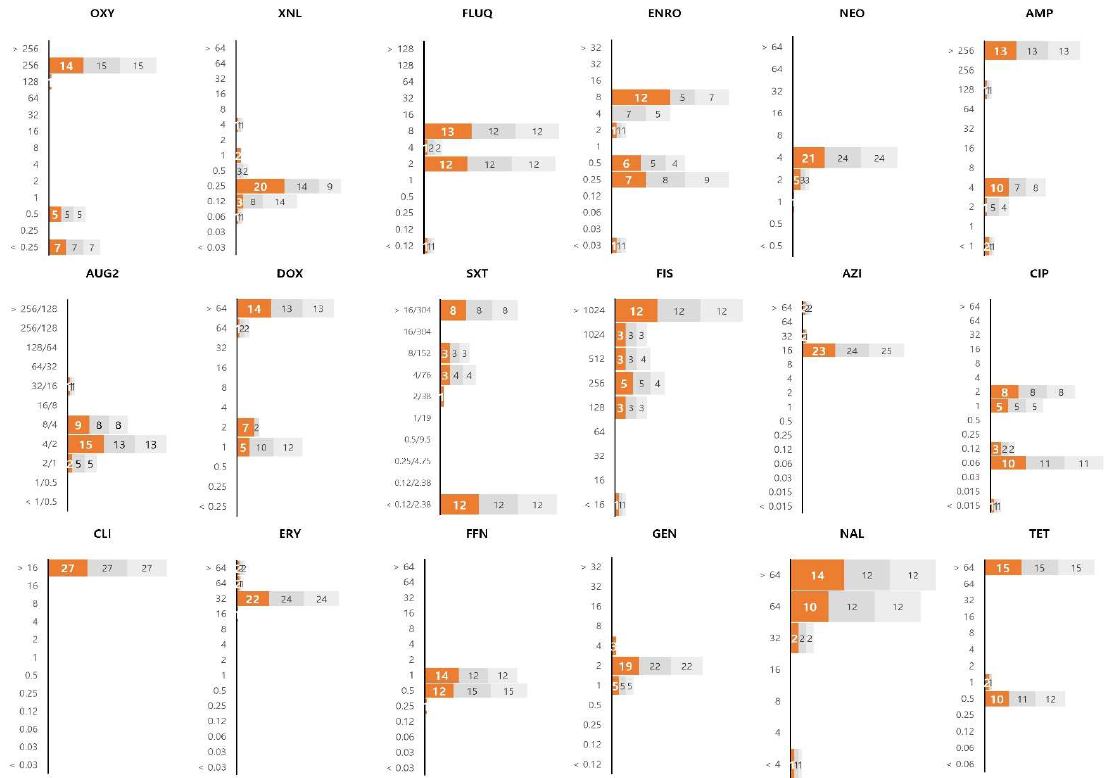
Figure 3. The MIC value distribution of 18 antibiotics against 27 strains of Edwardsiella piscicida isolated from olive flounders. The X and Y axes of the graph represent the number of isolates and the MIC ( μ g/mL), respectively. The results of the experiment repeated in triplicate are shown in colour on the graph (1st: orange, 2nd: dark gray, 3rd: light gray). Oxytetracycline: OXY; ceftiofur: XNL; flumequine: FLUQ; enrofloxacin: ENRO; neomycin: NEO; ampicillin: AMP; amoxicillin/clavulanic acid: AUG2; doxycycline: DOX; trimethoprim/sulfamethoxazole: SXT; sulfisoxazole: FIS; azithro- mycin: AZI; ciprofloxacin: CIP; clindamycin: CLI; erythromycin: ERY; florfenicol: FFN; gentamicin: GEN; nalidixic acid: NAL; tetracycline: TET.